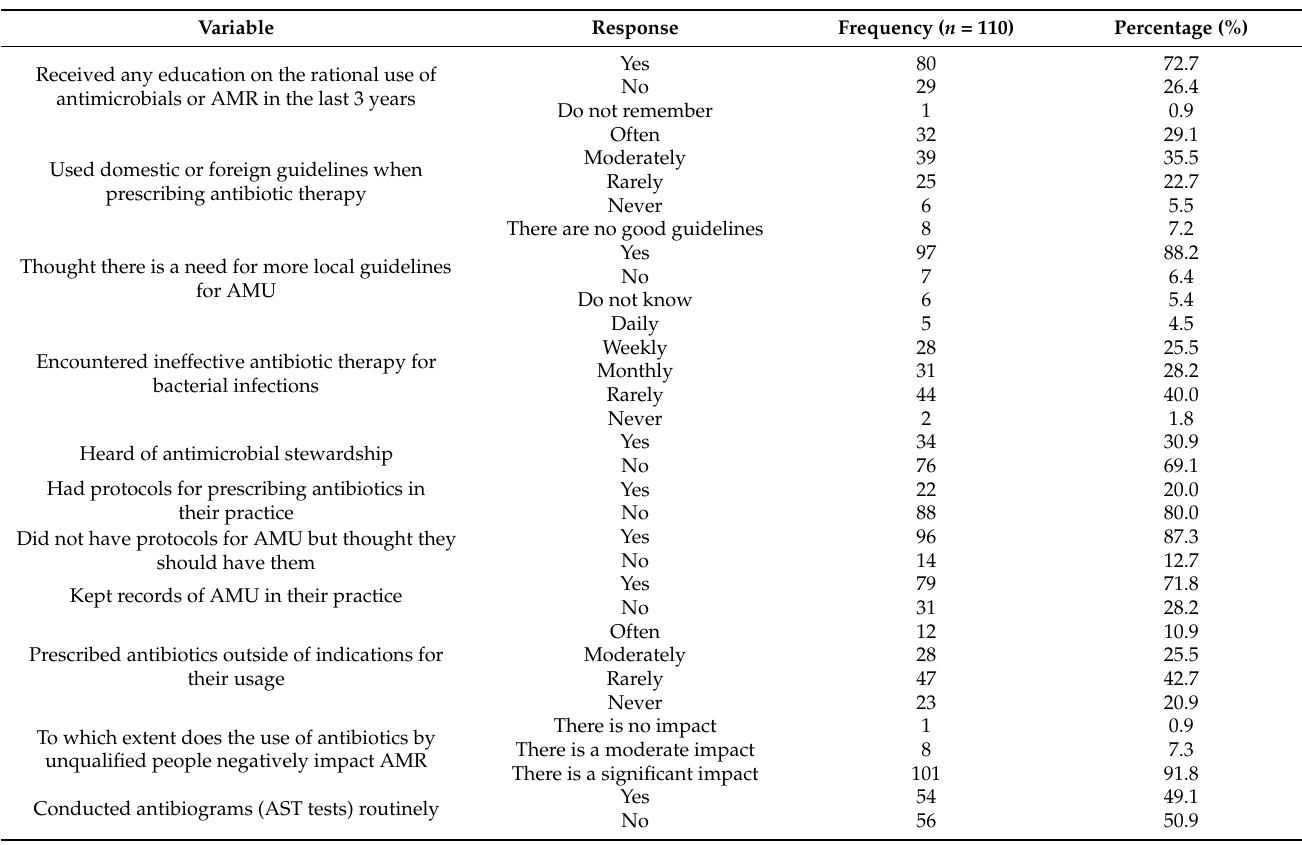
Table 2. Attitudes toward AMR.